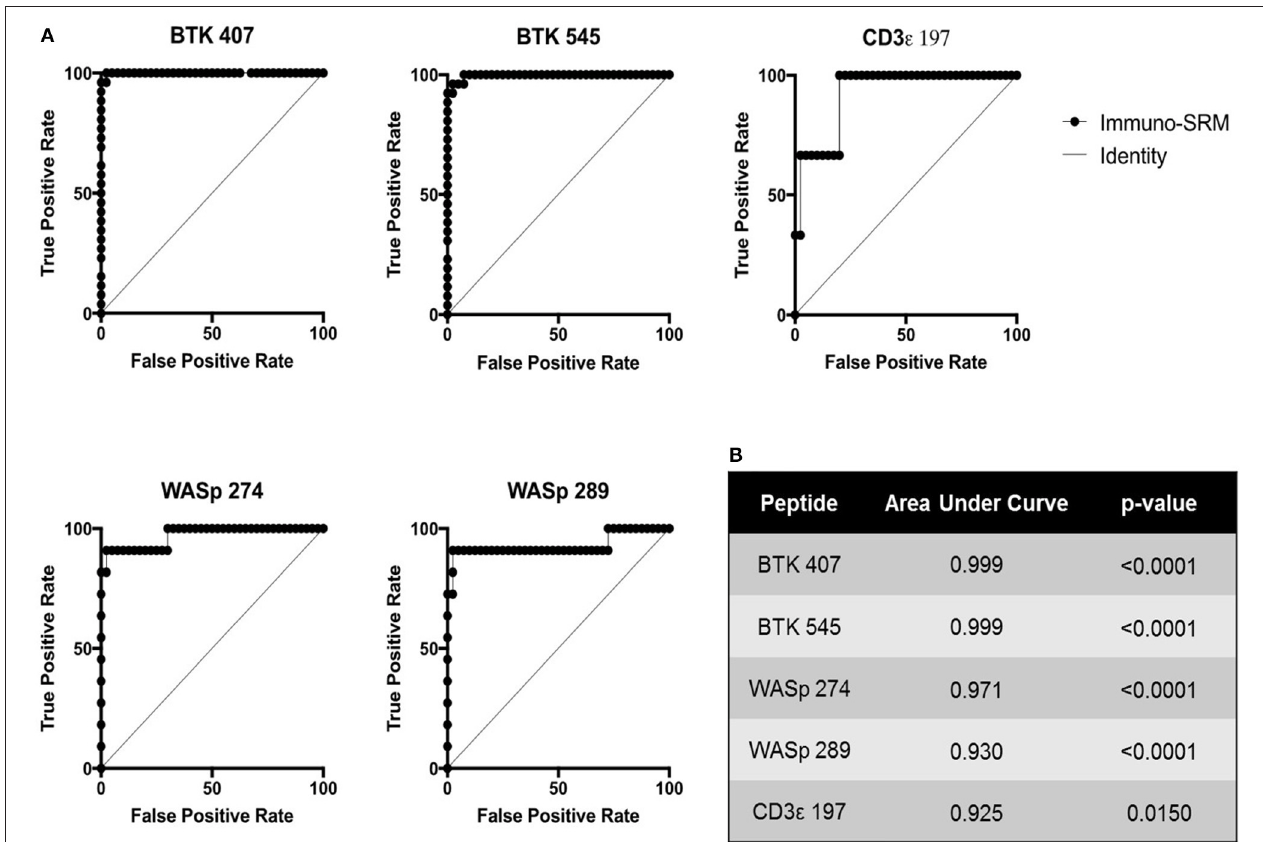
FIGURE 6 | ROC plots showing the diagnostic performance of Immuno-SRM for PIDDs. (A) ROC plots for each signature peptide. True positive and false positive rates are plotted for increasingly stringent cutoff values. Line of identity indicates a test that cannot distinguish patients from controls. (B) Area under the curve (AUC) values and p -values for each peptide of